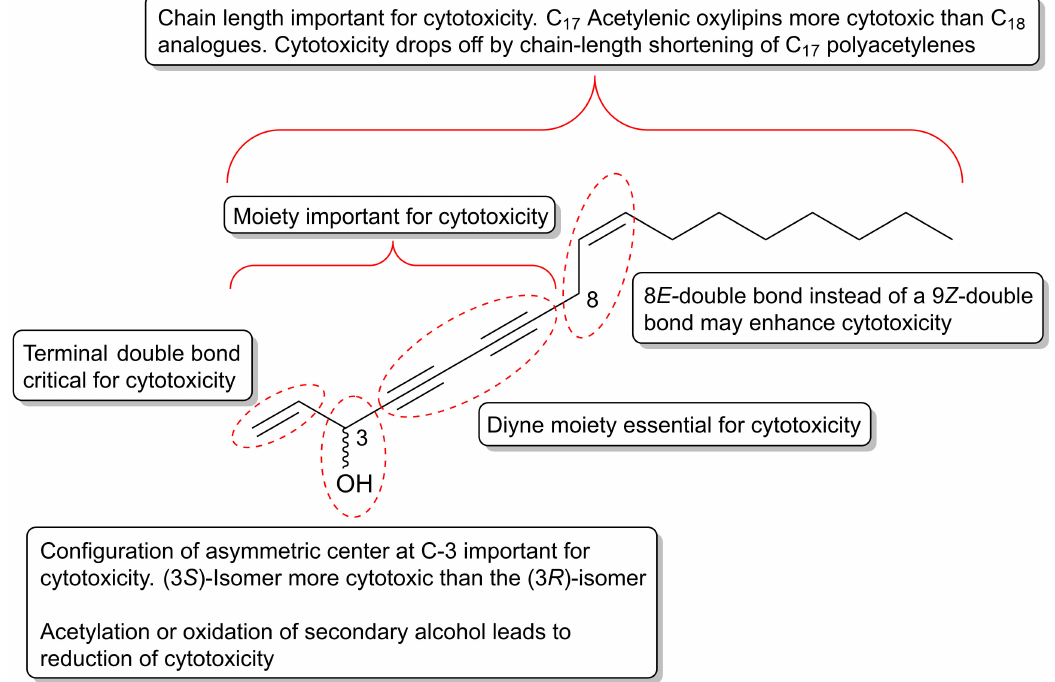
Figure 7. Illustration of moieties, stereochemistry and other structural requirements that are important for the cytotoxicity of C 17 and C 18 acetylenic oxylipins (falcarinol as an example) isolated from Apiaceae, Araliaceae, and Asteraceae families based on structural-activity relationship